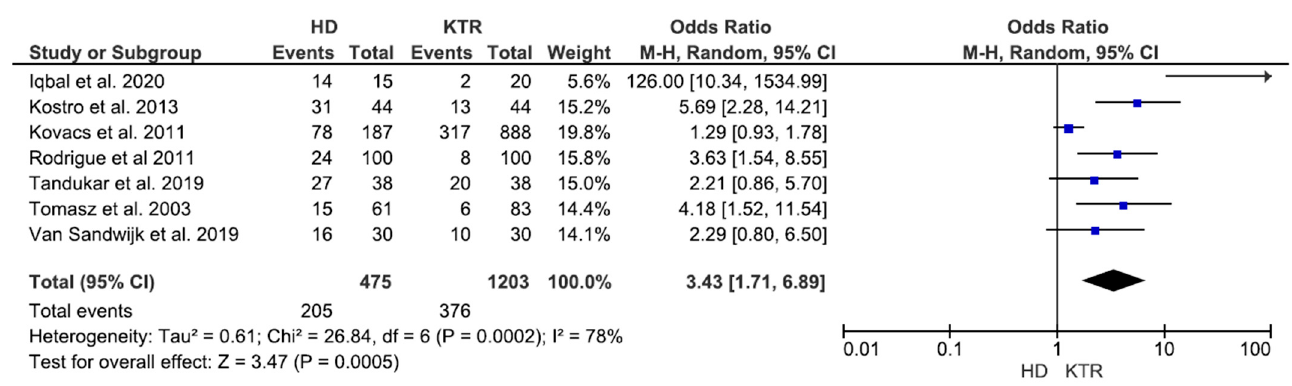
Figure 2. Forrest plot of studies reporting comparison between fatigue in HD and KTR subjects.